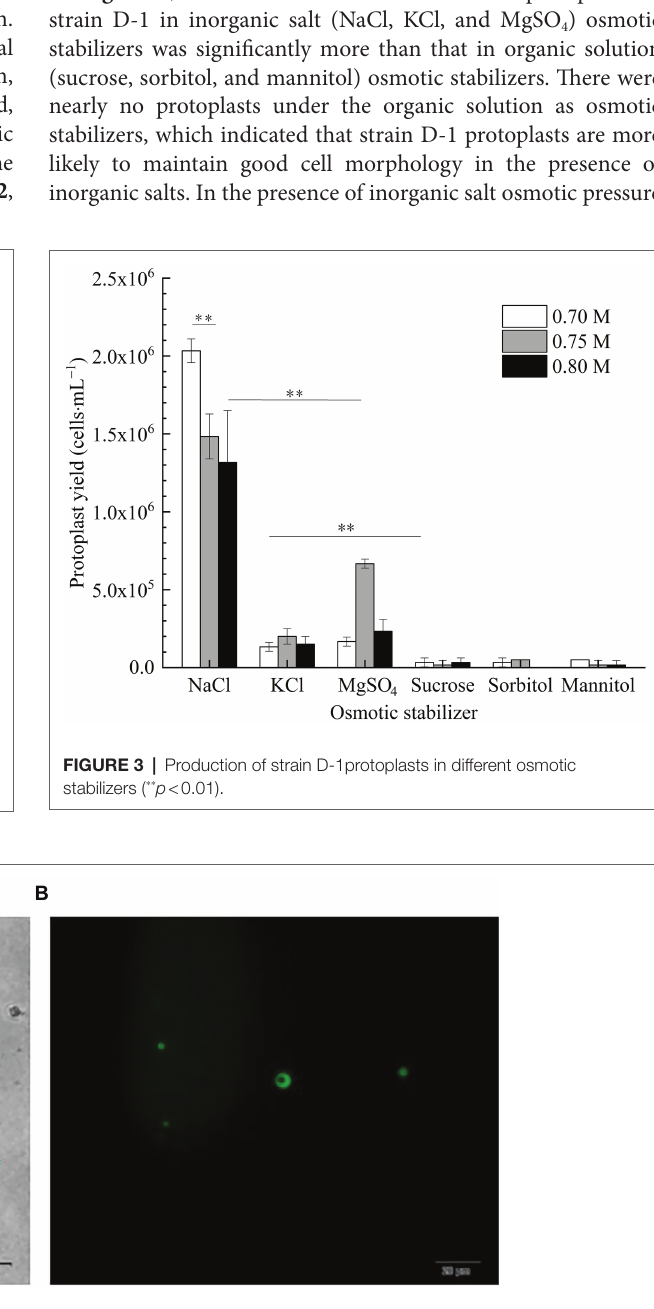
FIGURE 2 | Microscopic view of strain D-1 protoplasts (×400). (A) Bright field. (B) Fluorescence field.